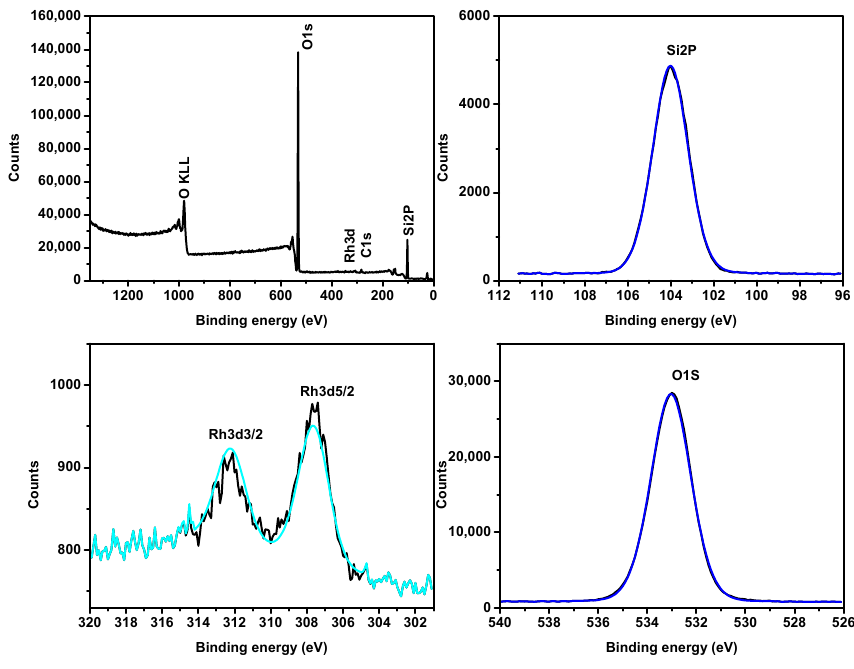
Figure 5. XPS analysis for the Rh-1 sample.